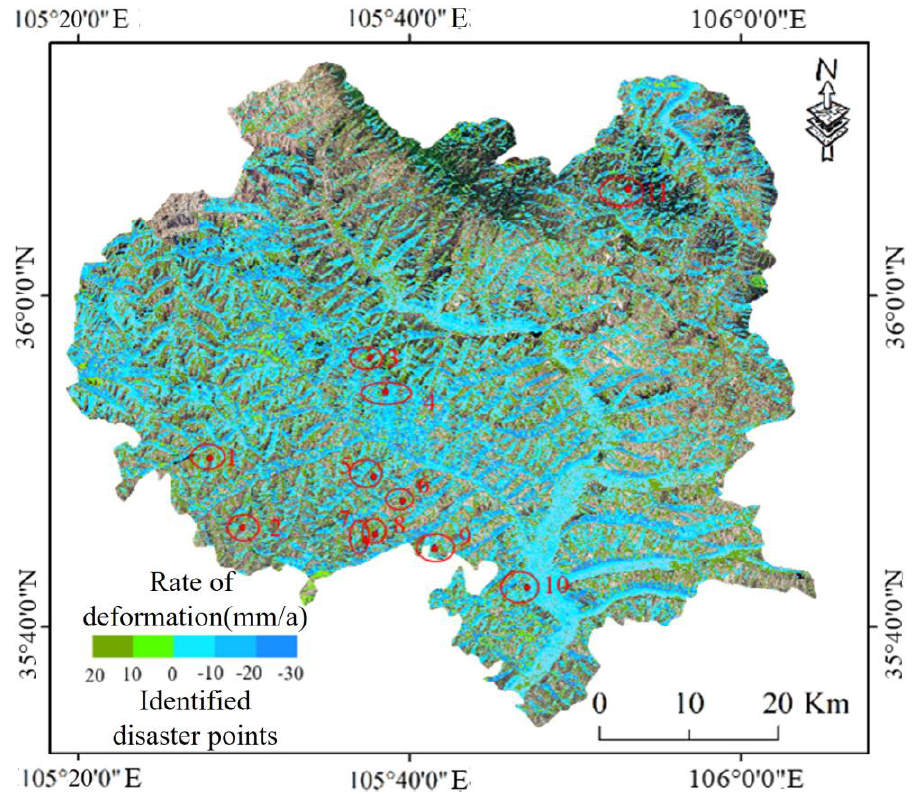
Figure 3. The annual average deformation rate on LOS.